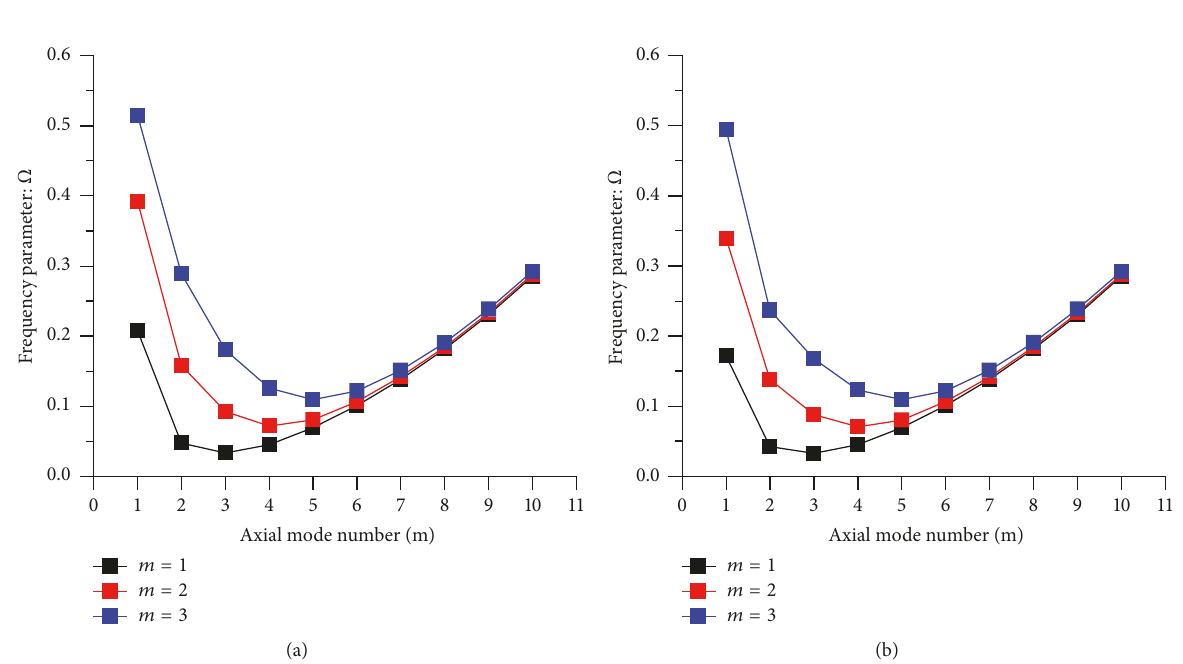
Figure 4: The change in frequency parameters for the axial and the circumferential wave number, (a) ECE vessel, (b) PCE vessel.